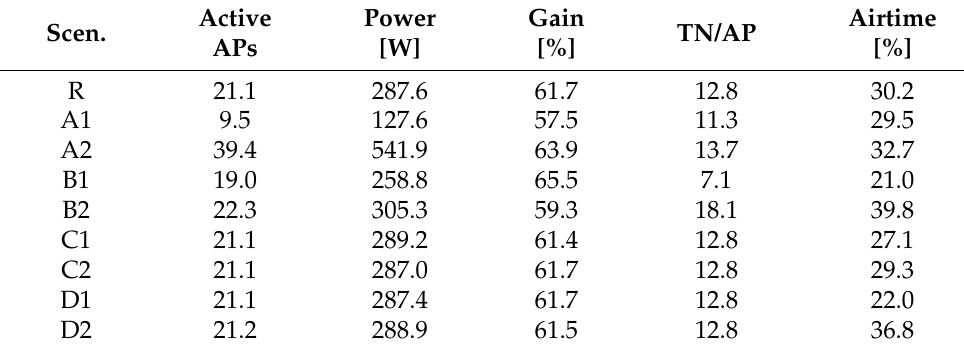
Table 4. Results for the scenarios with D = 42m.